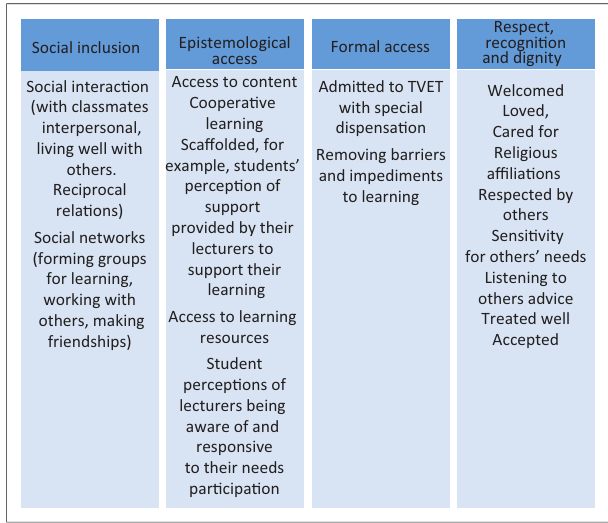
FIGURE 1 : Inclusion and inclusion